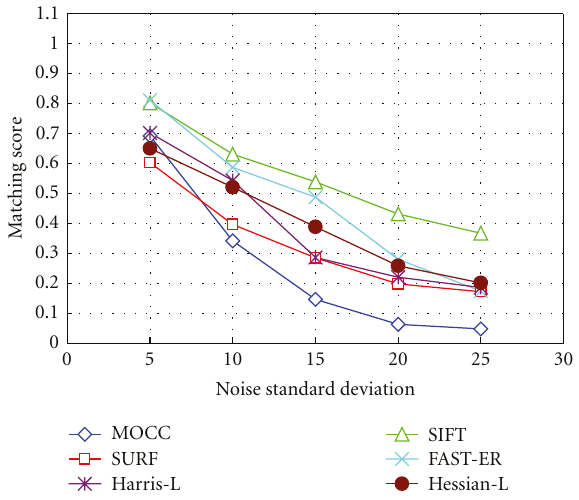
Figure 18: Matching results on images with Gaussian noise corruptions.